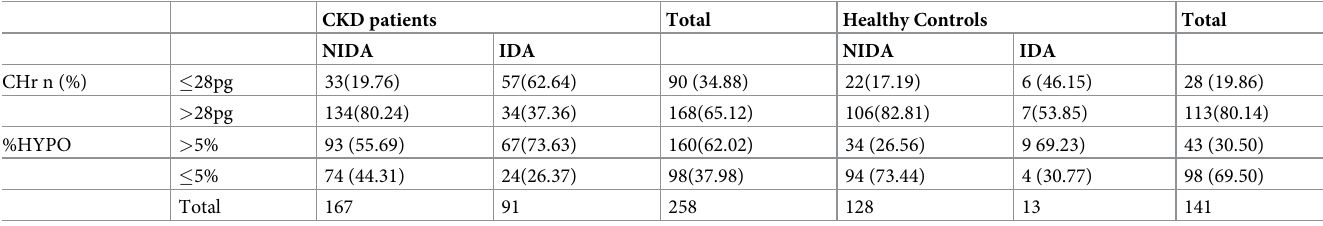
Table 4. Predictive ability of reticulocyte haemoglobin content and percentage hypochromic red cells using TSAT and ferritin as reference parameters among chronic kidney disease participants and healthy controls.